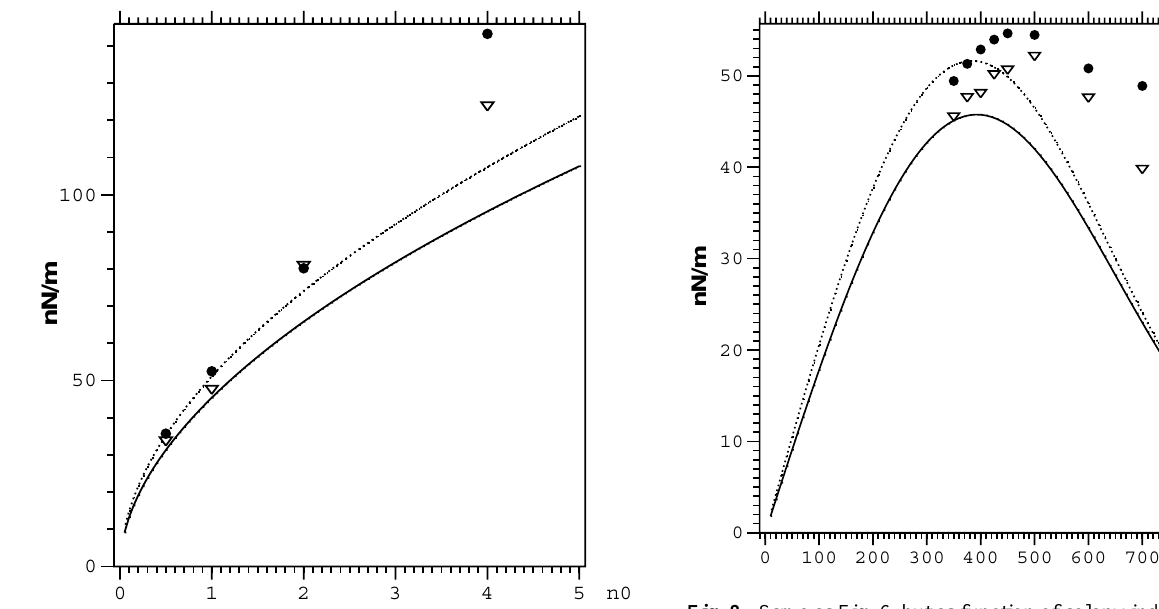
Fig. 8. Same as Fig. 6, but as function of solar wind speed.